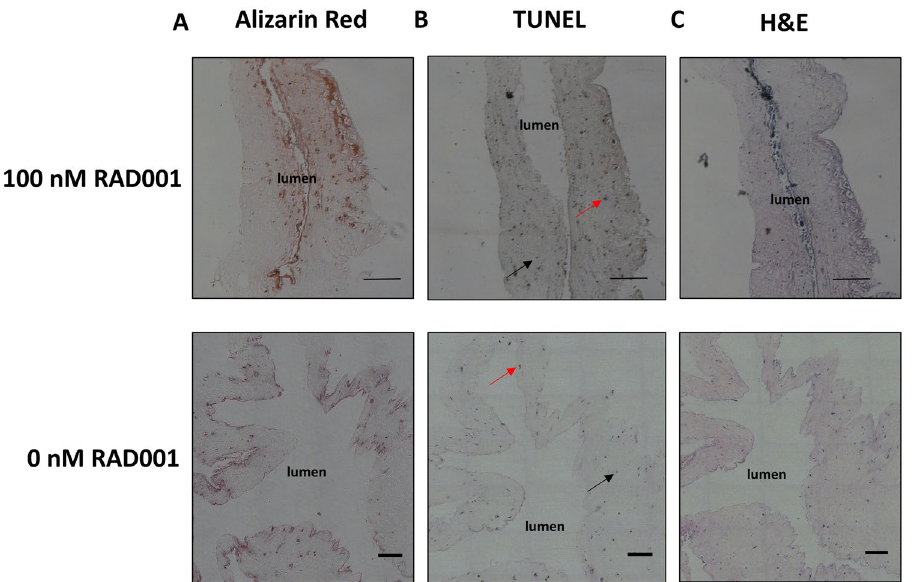
Figure 6. Histochemical analysis of HGPS TEBVs treated with Everolimus vs. untreated controls. ( A ) Alizarin Red stain, ( B ) TUNEL stain and ( C ) H&E stain of HGPS iSMC TEBVs after 3 weeks of normal perfusion and 1 week of treatment with 100 nM RAD001 or HGPS iSMC TEBVs without treatment. Red arrows indicate TUNEL positive cells and black arrows indicate TUNEL negative cells (Scale bar, 200 μ